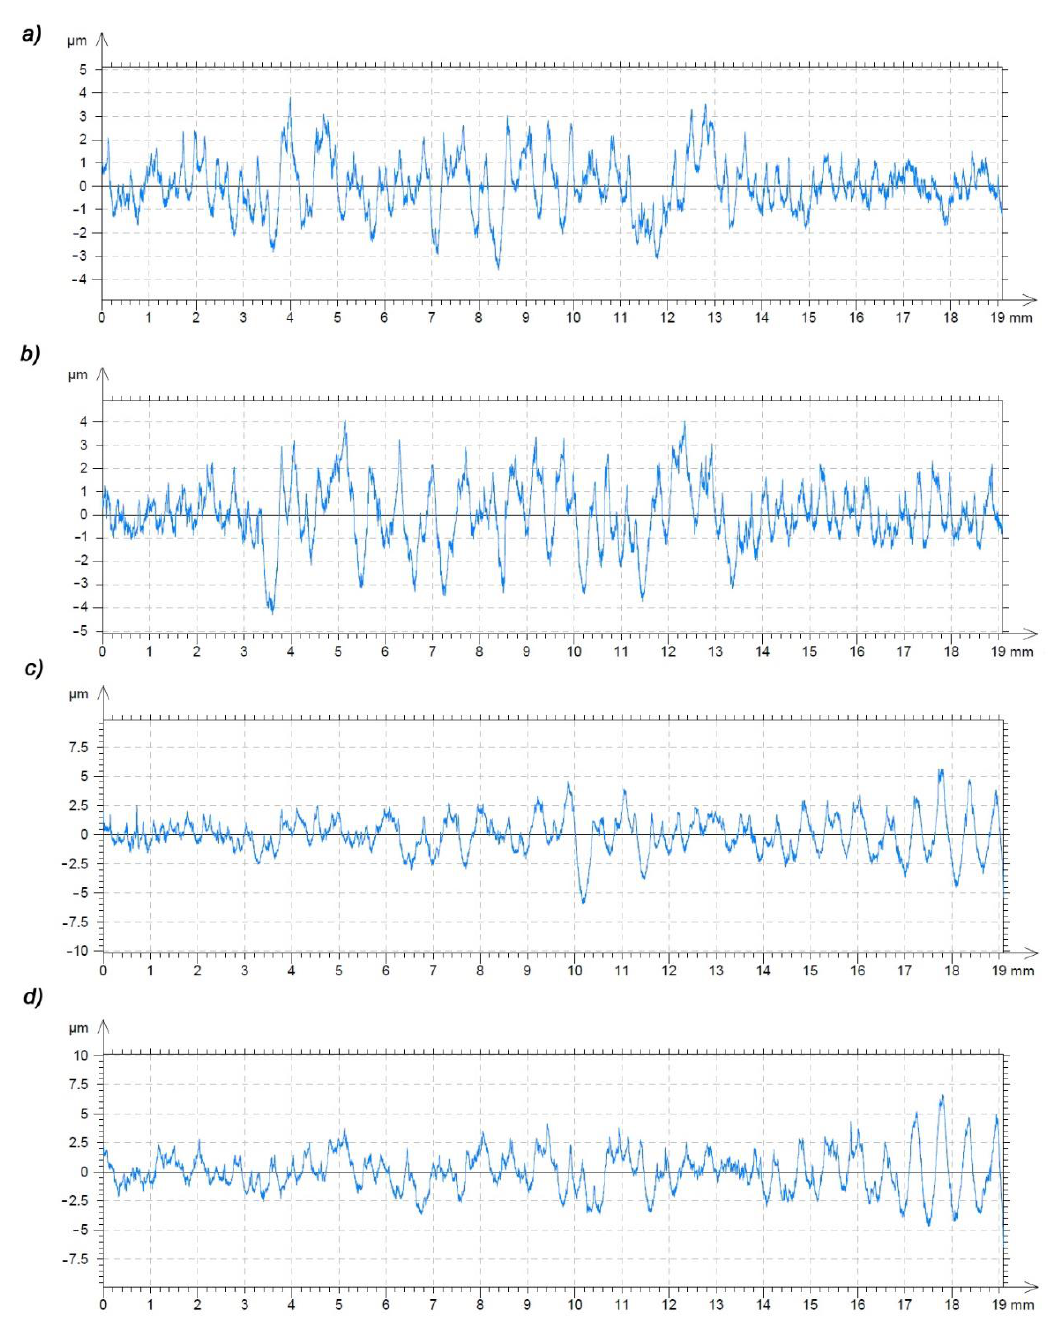
Figure 18. Profile of the roughness parameter R a measured along the tooth line for the size of the feed parameters: ( a ) 2000 (mm/min), ( b ) 2600 (mm/min), ( c ) 3200 (mm/min), ( d ) 4000 (mm/min); PVDA without heat treatment.